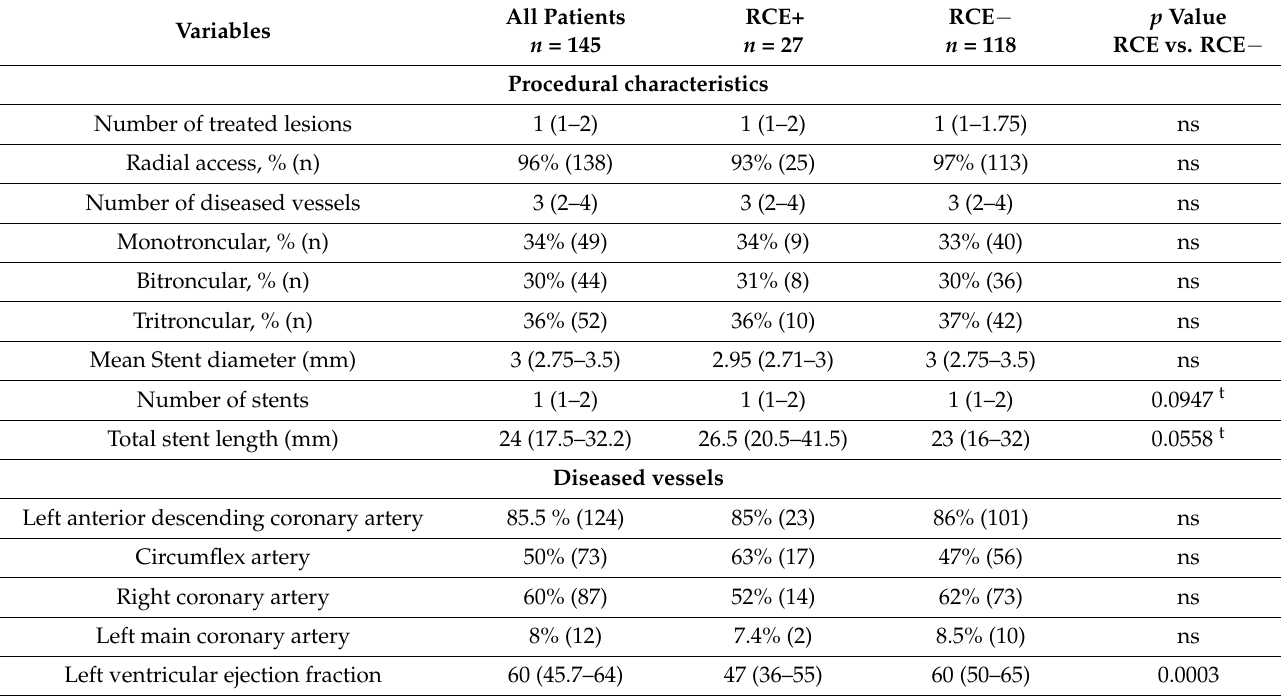
Table 1. Angiographic and interventional characteristics of the study